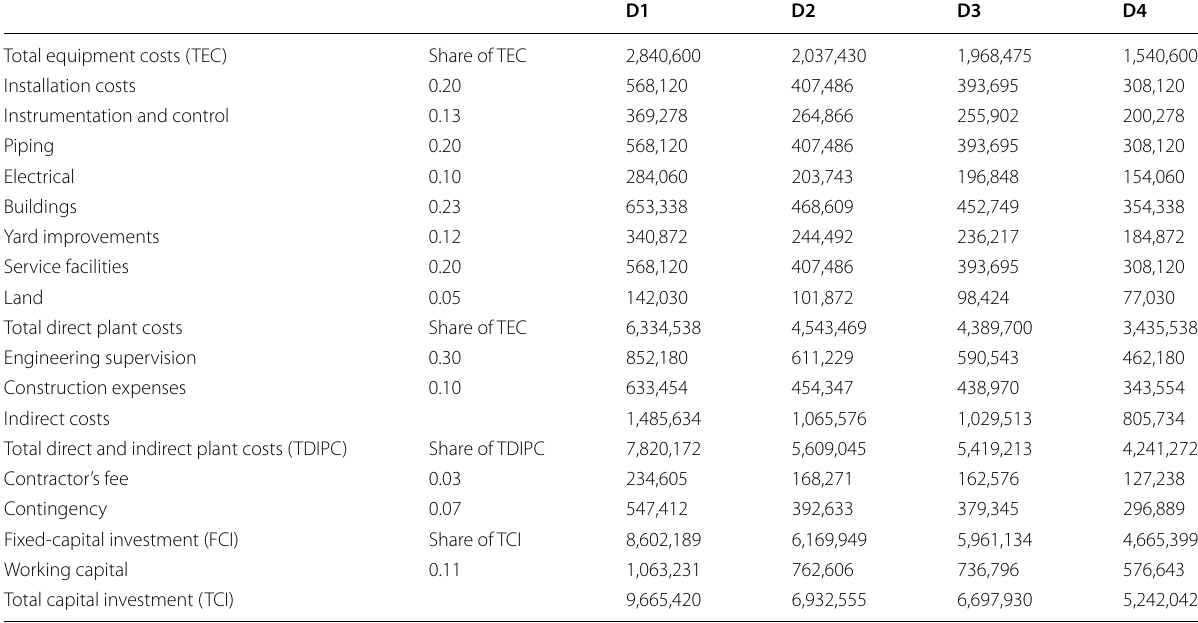
Table 5 List of the total direct plant costs, the indirect plant costs, the fixed-capital investment and the total capital investment of the four downstream processes D1, D2, D3, and D4